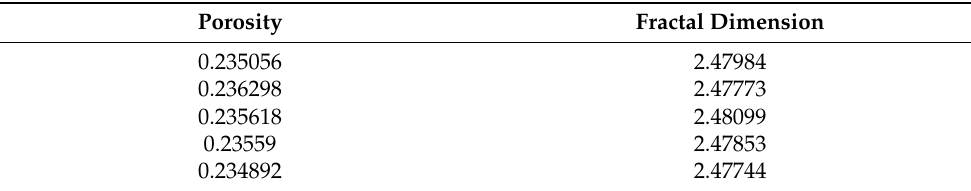
Table 1. Fractal Dimension.